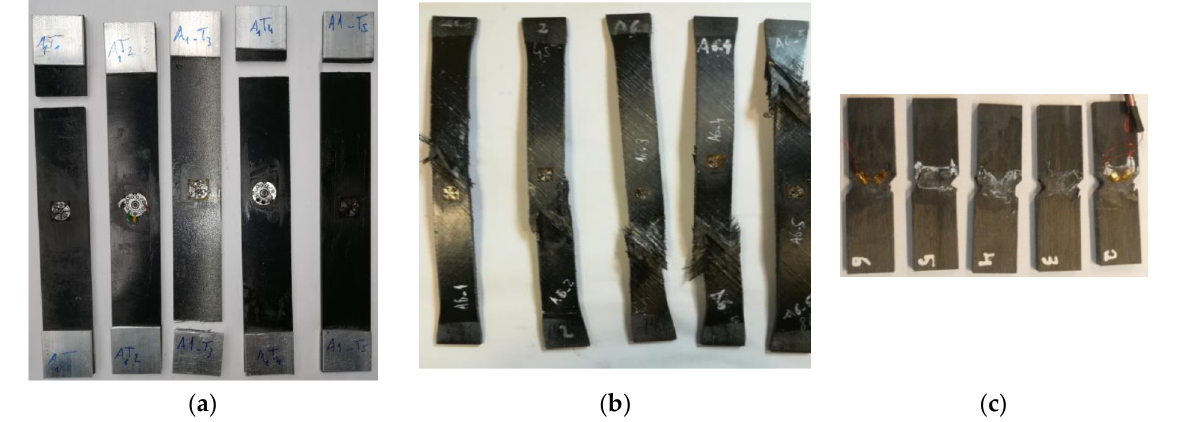
Figure 6. Coupons after testing. ( a ) Transverse tensile tests, ( b ) Longitudinal shear tests and ( c ) Transverse shear tests.